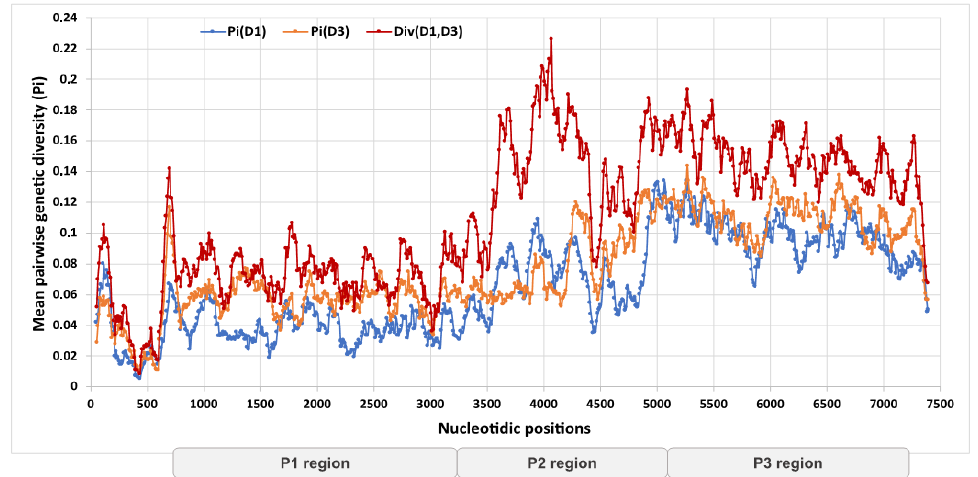
Figure 2. Genetic diversity among the coxsackievirus A6 genomes determined in this study. The mean pairwise genetic diversity was calculated between the 213 CVA6 complete genomes assigned to subclades D1 and D3. The intra-clade nucleotide diversity (Pi) and inter-clade divergence (Div) were calculated as a mean proportion using a sliding window of 100 nts with a step size of 10 nts. Locations of genomic regions in the alignment: P1, nucleotide positions 748–3357; P2, nucleotide positions 3358–5349; P3, nucleotide positions 5350–7351.